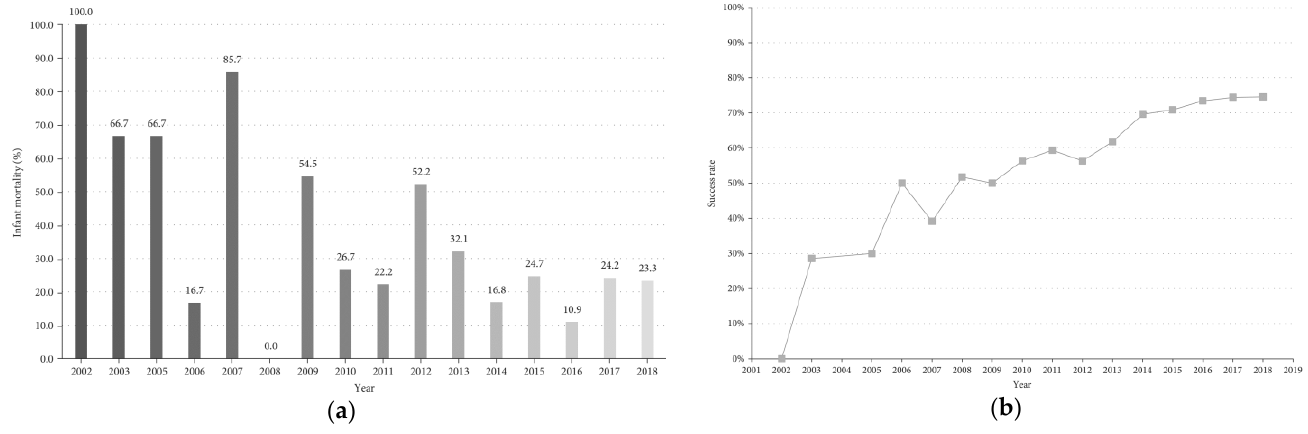
Figure 1. Infant mortality ( a ) and success rate ( b ) of CubeSat missions from 2000–2020. Reprinted from ref. [1]. Looking at available data, such as from the University of Saint Louis [2], it can be seen that, especially in the early 2000s, CubeSats have been developed and deployed almost exclusively from universities, as seen in Figure 2.